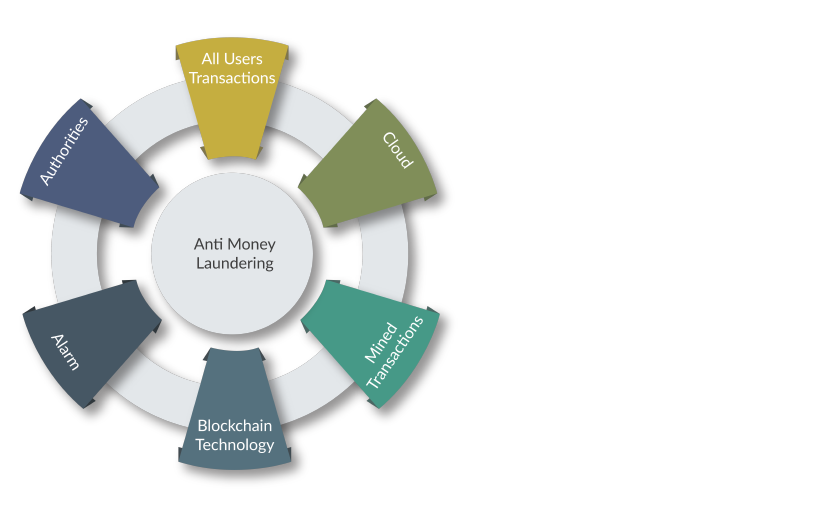
Figure 1. Simple anti-money laundering process with the data mining and blockchain-enabled features.